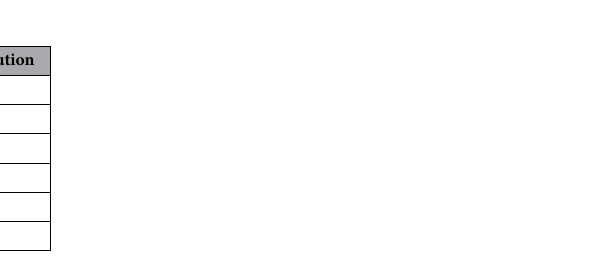
Table 6. Summary of basic physical properties for Loess samples; Lv Liang. Min minimum, Q1 1st quantile, Q3 3rd quantile, Max